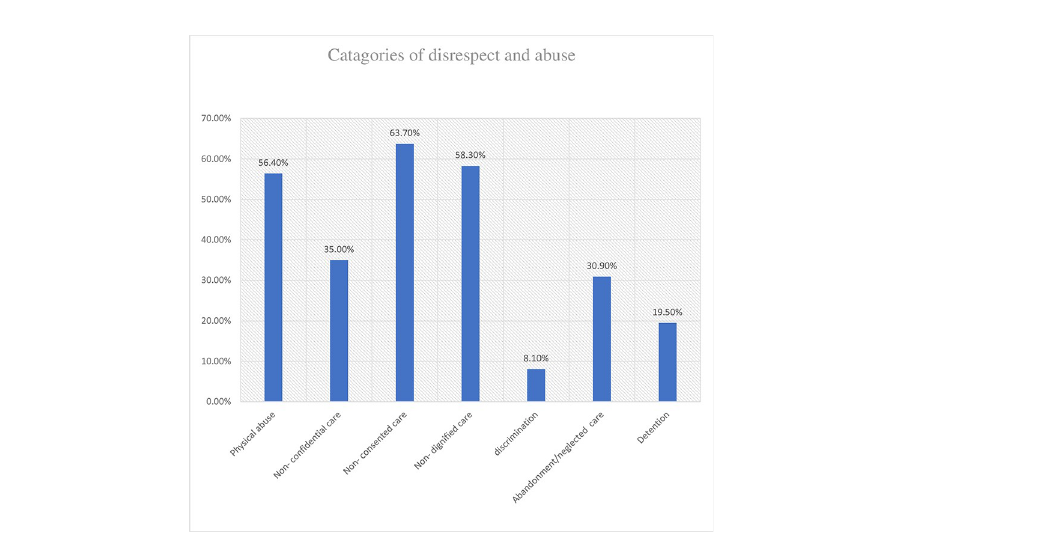
Fig 2. Percentage of each category of disrespect and abuse during facility-based childbirth in Borena District, South Wollo, Amara region, Ethiopia, 2020 (n = 369).